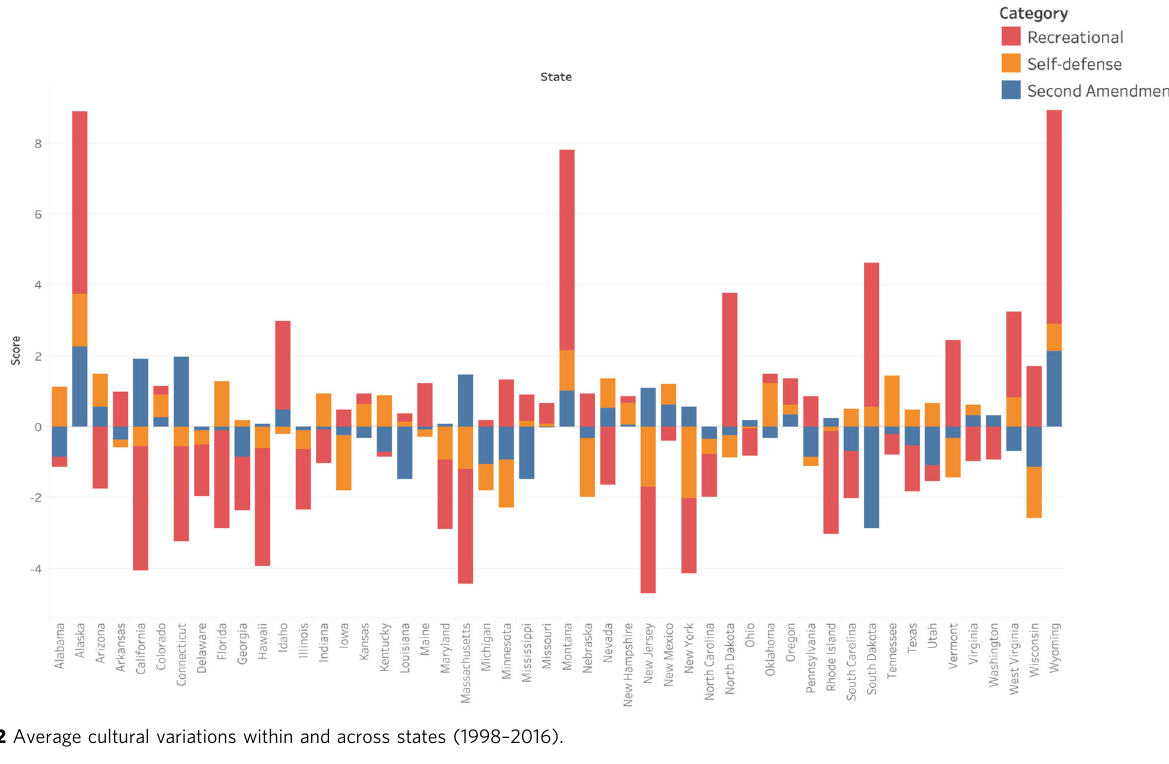
Fig. 2 Average cultural variations within and across states (1998 –